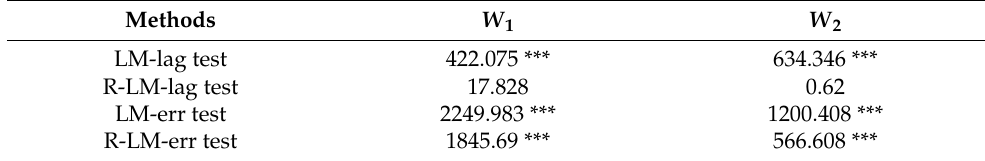
Table 3. Spatial models specification results.